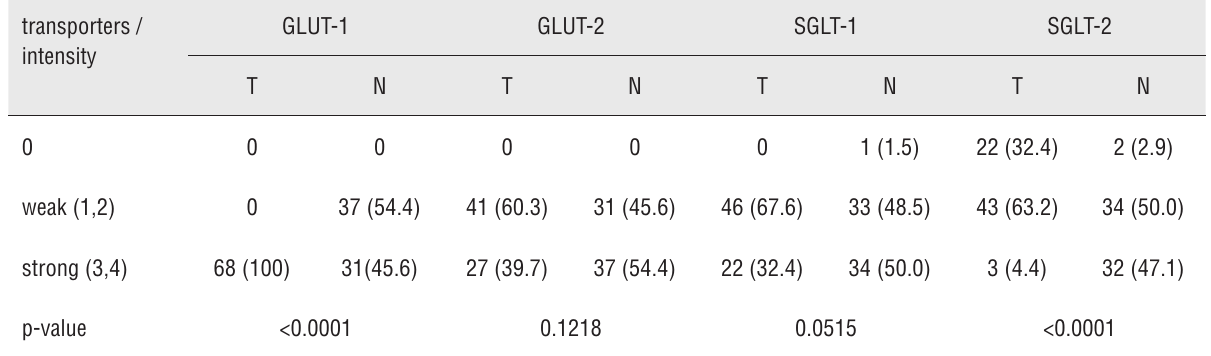
no. of cases (%) T = tumor; N = normal P-valus were determined by Fisher's exact test.